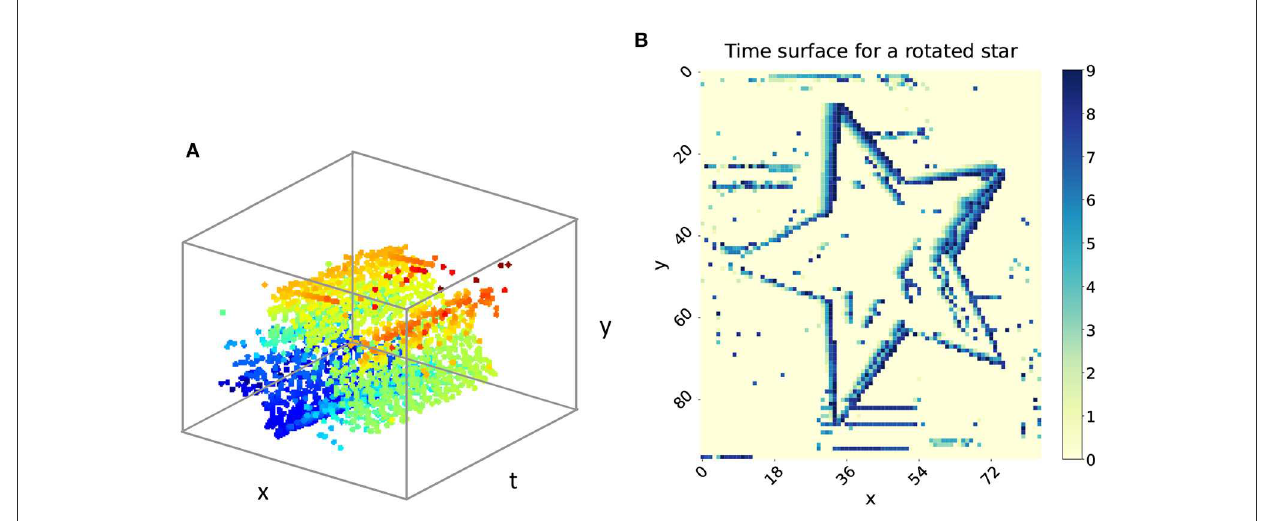
FIGURE1 (A) The 3D visualization of the rotated star. (B) The time surface of the rotated star.